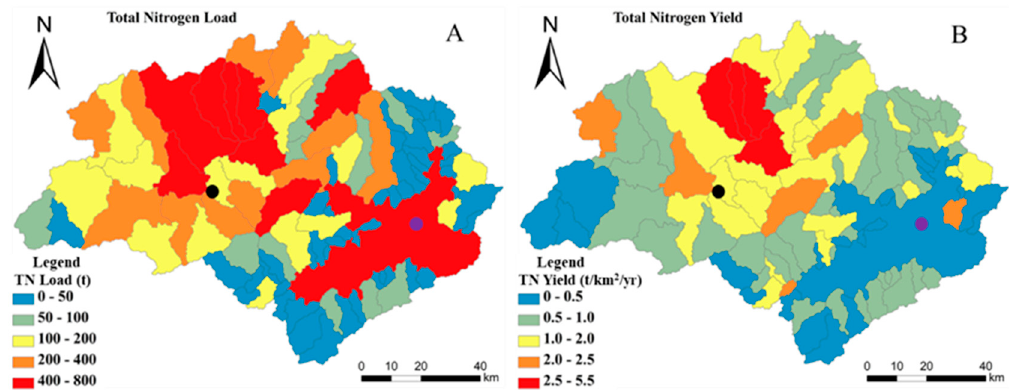
Figure 6. Spatial distribution of annual ( A ) TN loads and ( B ) TN yields among the sub-basins of the QLB. The locations of the urban core of Huangshan City (black dots) and Chun’an County (purple dots) are indicated.